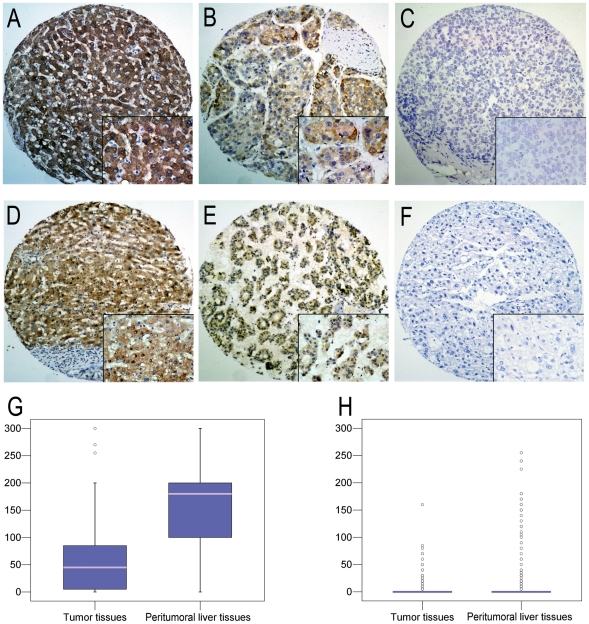
The expression patterns of ZEB2 in HCC and peritumoral liver tissues by IHC.(A) Overexpression of Cytoplasmic ZEB2 was shown in the peritumoral liver tissues (case 52), in which more than 95% hepetocytes revealed positive staining of ZEB2 in cytoplasm (×100). (B) The tumor tissues (case 37) demonstrated overexpression of cytoplasmic ZEB2, in which more than 85% of tumor cells showed immunoreactivity of ZEB2 in cytoplasm (×100). (C) Normal expression of ZEB2 was observed in a HCC case (case 52), in which less than 10% of tumor cells showed immunoreactivity of ZEB2 in cytoplasm (×100). (D) Nuclear overexpression of ZEB2 was shown in the peritumoral liver tissues (case 89), in which more than 80% hepetocytes revealed positive staining of ZEB2 in nuclei (×100). (E) The tumor tissues (case 76) demonstrated overexpression of nuclear ZEB2, in which more than 70% of tumor cells showed immunoreactivity of ZEB2 in nuclei (×100). (F) Negative expression of ZEB2 was observed in a HCC case (case 89, ×100). Representative sites with higher (inset, ×400) magnification were shown. (G) The box plot shows the mean staining intensity of cytoplasmic ZEB2 from HCC and peritumoral liver tissues (P<0.0001). (H) The box plot demonstrates the range of nuclear ZEB2 expression within each group (HCC, n = 248; peritumoral liver tissue, n = 248; P<0.0001).